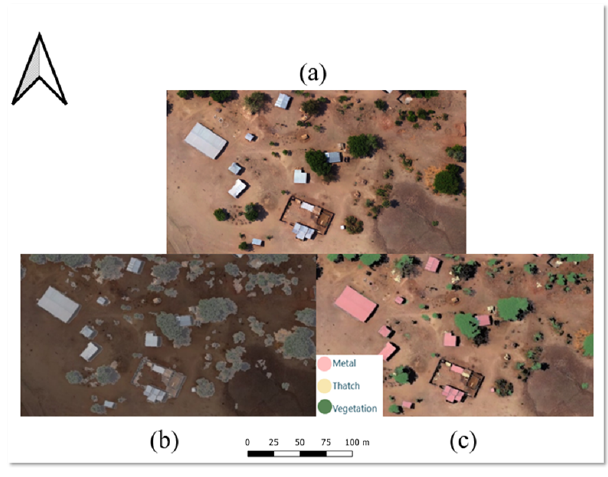
Figure 5. Steps of the OBIA: (a) original UAV imagery, (b) result of mean shift segmentation and (c) classification using SVM classi- fier. The image contains UAV imagery collected by the Malawi Red Cross Society (MRCS), collected in November 2018. Made with